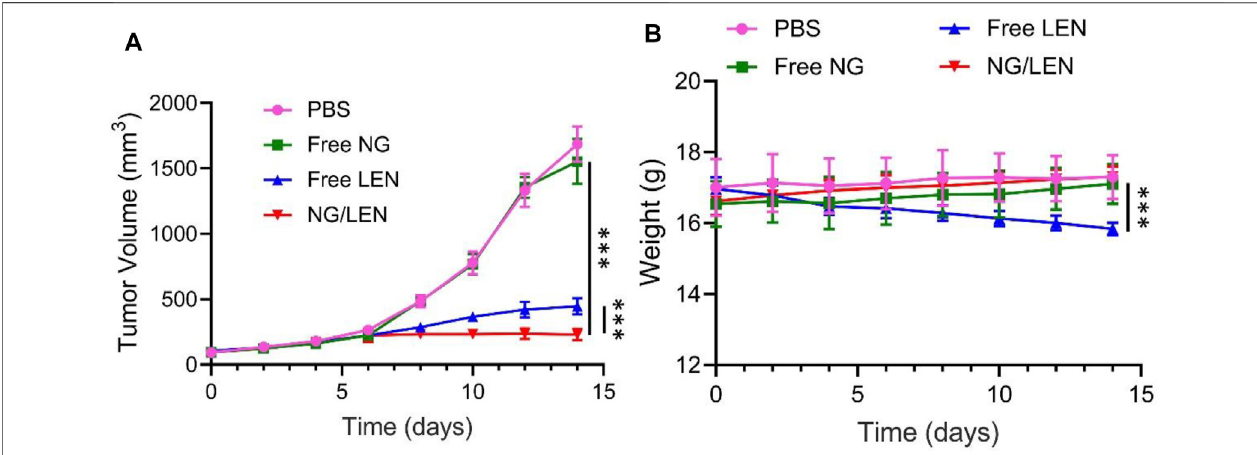
FIGURE5|(A) Invivo tumorinhibitionef fi caciesofPBS,freeNG,freeLEN,orNG/LENonmousemodelofsubcutaneousHCCtumormodeland (B) corresponding body weight change during treatment. Each set of data is represented as mean ± SD ( n (cid:1) 6; *** p < 0.001).